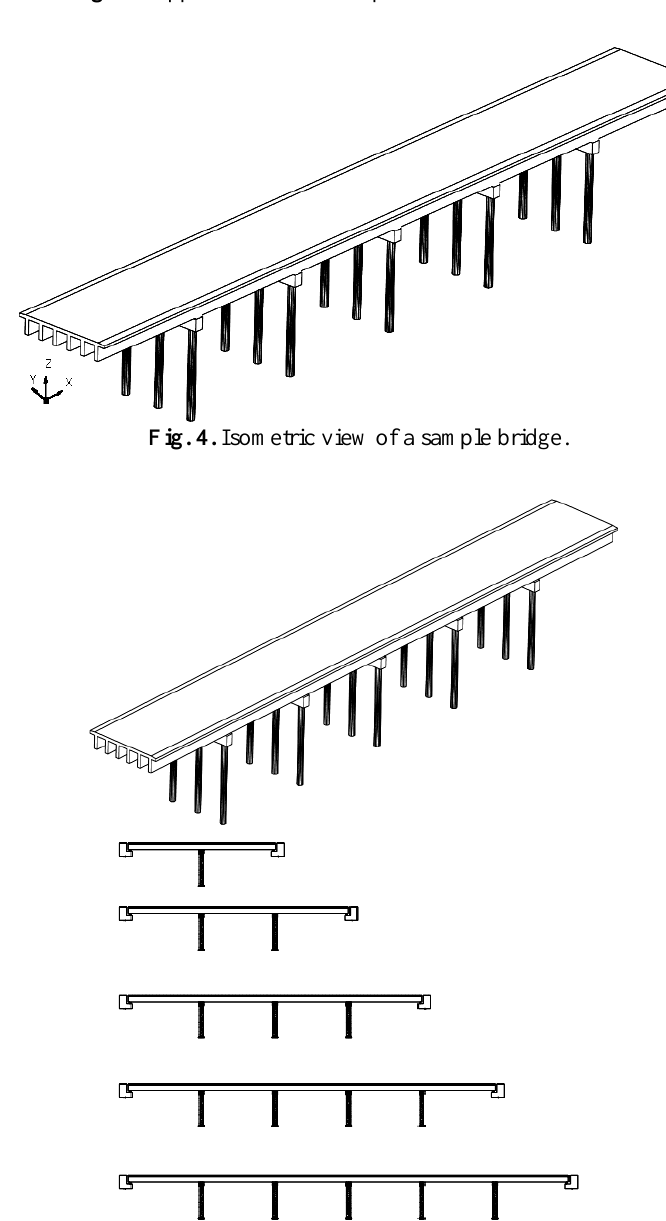
Fig. 5. Elevation of bridges in longitudinal